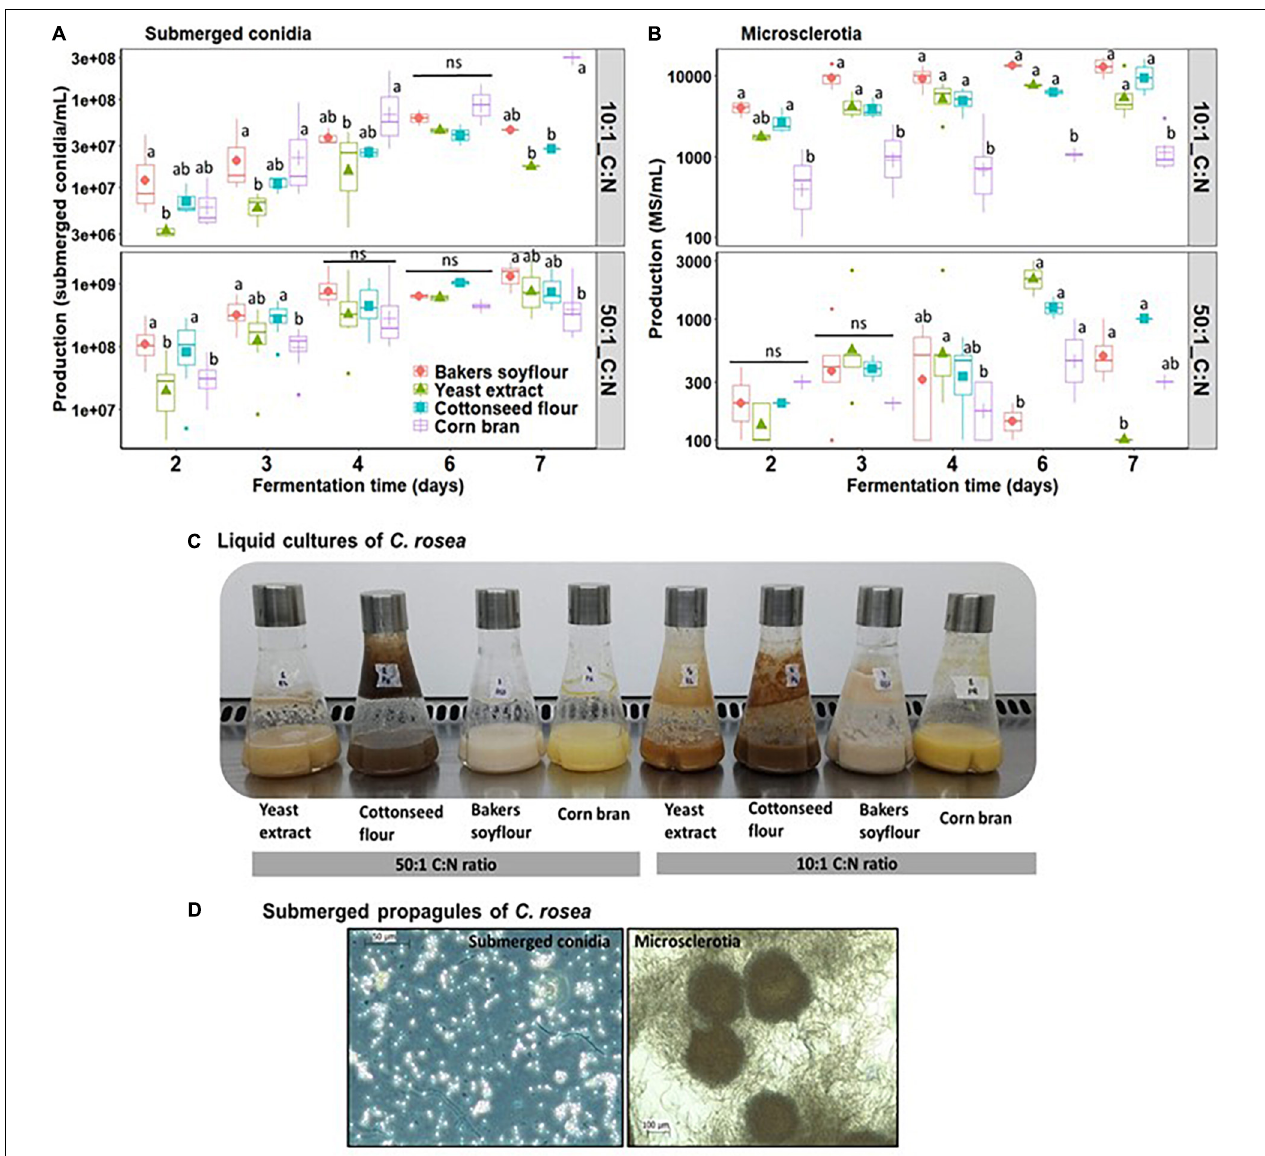
FIGURE 2 | Effect of nitrogen interaction and C:N ratio on the production kinetics of submerged conidia (A) and MS (B) of C. rosea (strain CMAA1284) under submerged liquid culture in shake flasks. (C) Liquid cultures of C. rosea cultivated in shake flasks after 7 days of cultivation. (D) Microphotographs of submerged conidia and MS observed under light microscopy at 400 × and 200 × magnification, respectively. The means followed by the same letter within each time interval and C:N ratio (10:1 or 50:1) indicate that the nitrogen sources do not differ from each other (Tukey HSD, p <